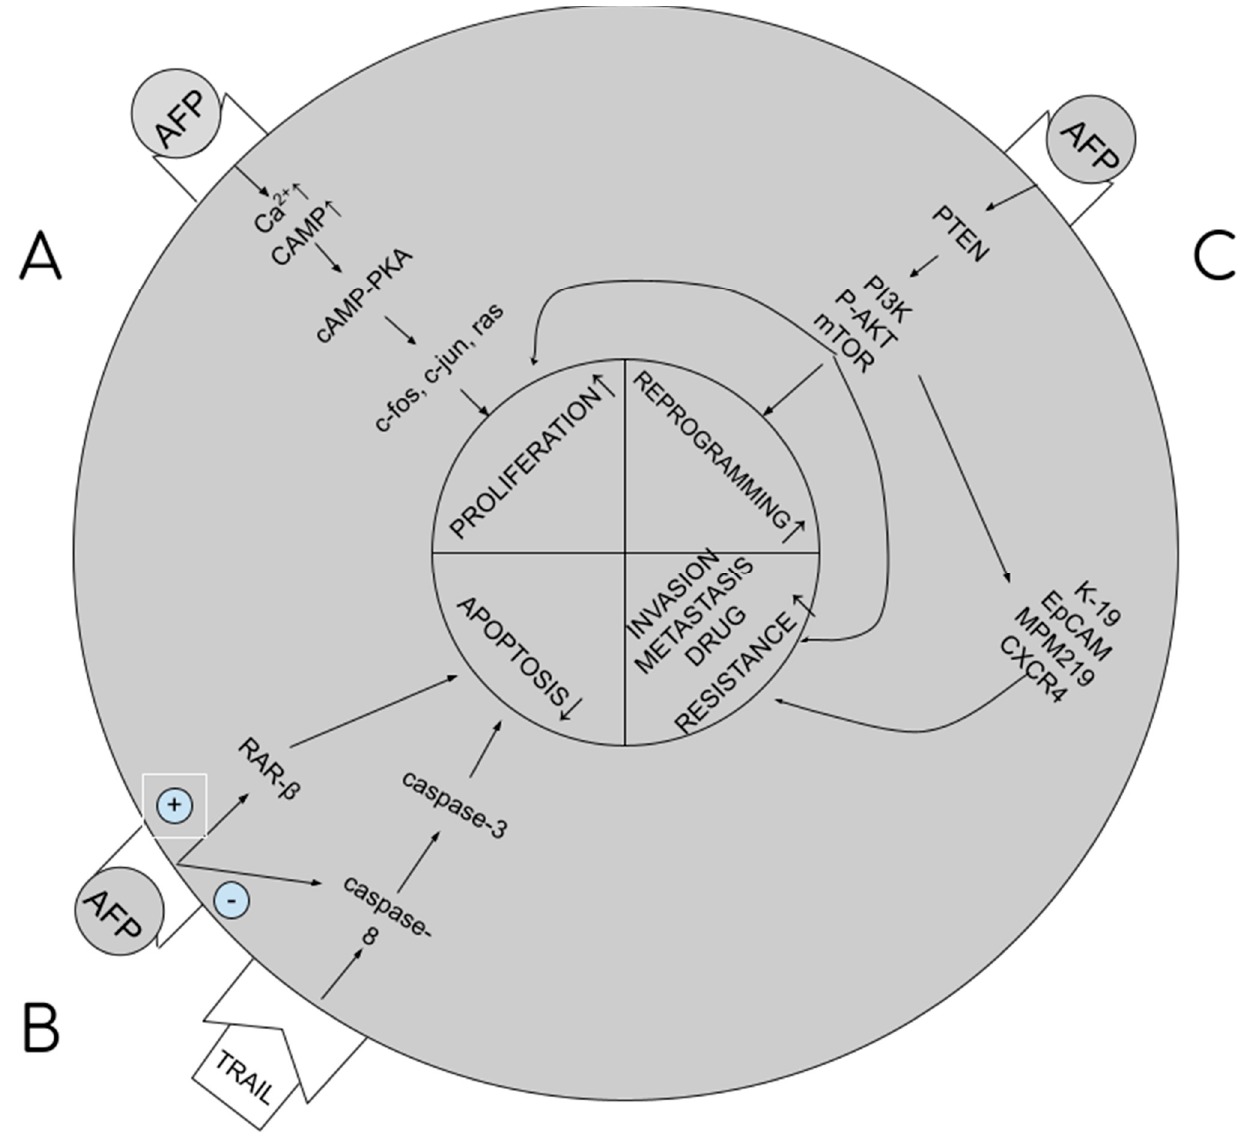
Figure 1. AFP influence on carcinogenesis. A . Stimulation of proliferation. B . Blockage of apoptosis. C . Stimulation of reprogramming, metastasis and multidrug resistance development.